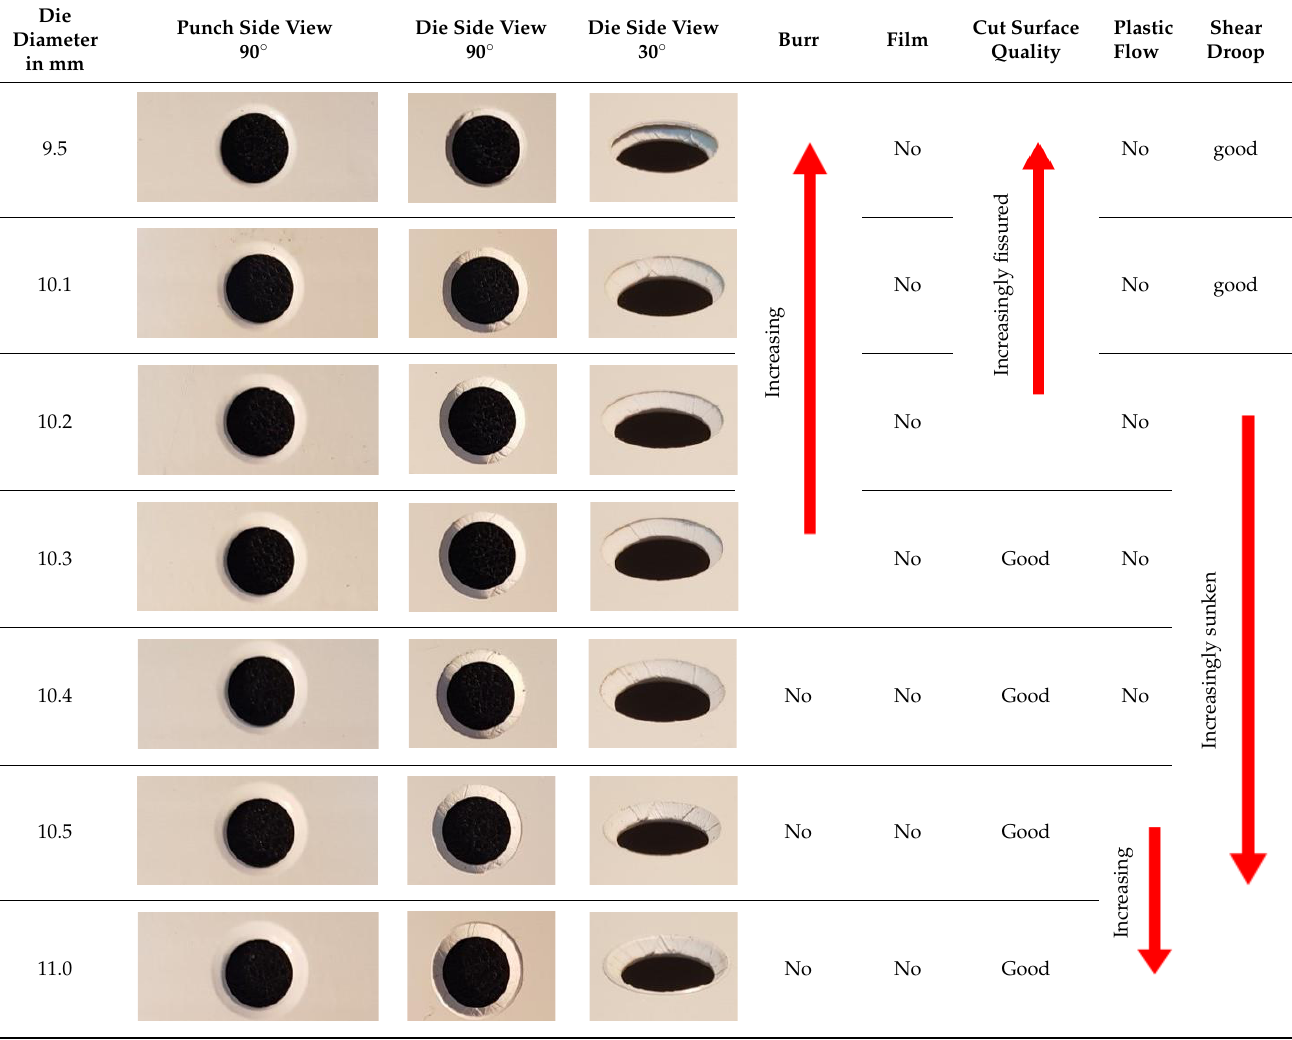
Table 1. Experimental results.